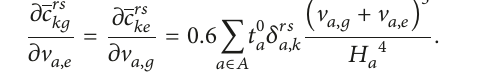
Figure 1: Illustration of subpaths definitions. We consider a path 𝑘 ofO-Dpair (𝑟,𝑠) ,alongwhichnodes 𝑖 and 𝑗 arelocatedinthemiddle of links 𝑎𝑏 , 𝑏𝑠 , respectively. There exist 3 pure subpaths denoted by dottedlines,namely, 𝑘 𝑟𝑖 , 𝑘 𝑖𝑗 ,and 𝑘 𝑗𝑠 ,andanother3subpaths 𝑘 𝑟𝑗 , 𝑘 𝑟𝑠 , and 𝑘 𝑖𝑠 by solid lines on path 𝑘 . These subpaths are feasible if their distance is less than the BEV driving distance limit 𝐷 𝑒